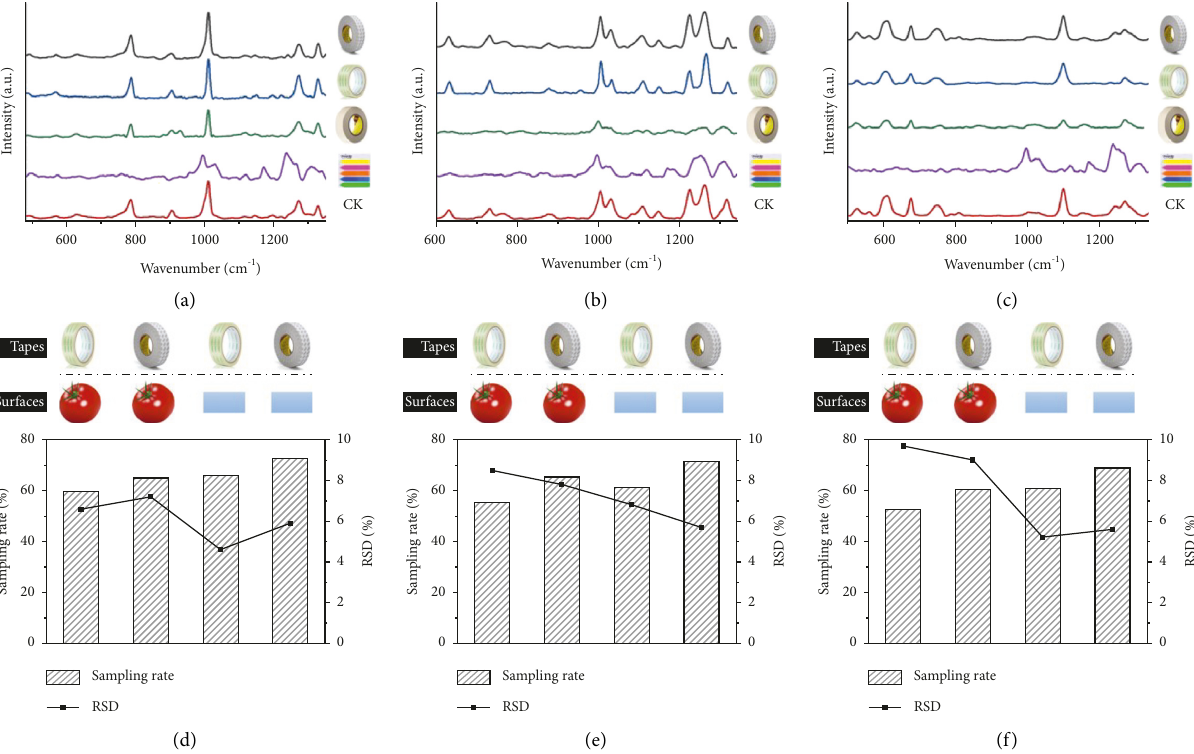
Figure 3: Raman spectra of (a) thiabendazole, (b) carbendazim, and (c) chlorpyrifos on different commercial tapes. Sampling performance of (d) thiabendazole, (e) carbendazim, and (f) chlorpyrifos collected from different surfaces on different commercial tapes. CK represents surface-enhanced Raman spectra of the corresponding pesticide